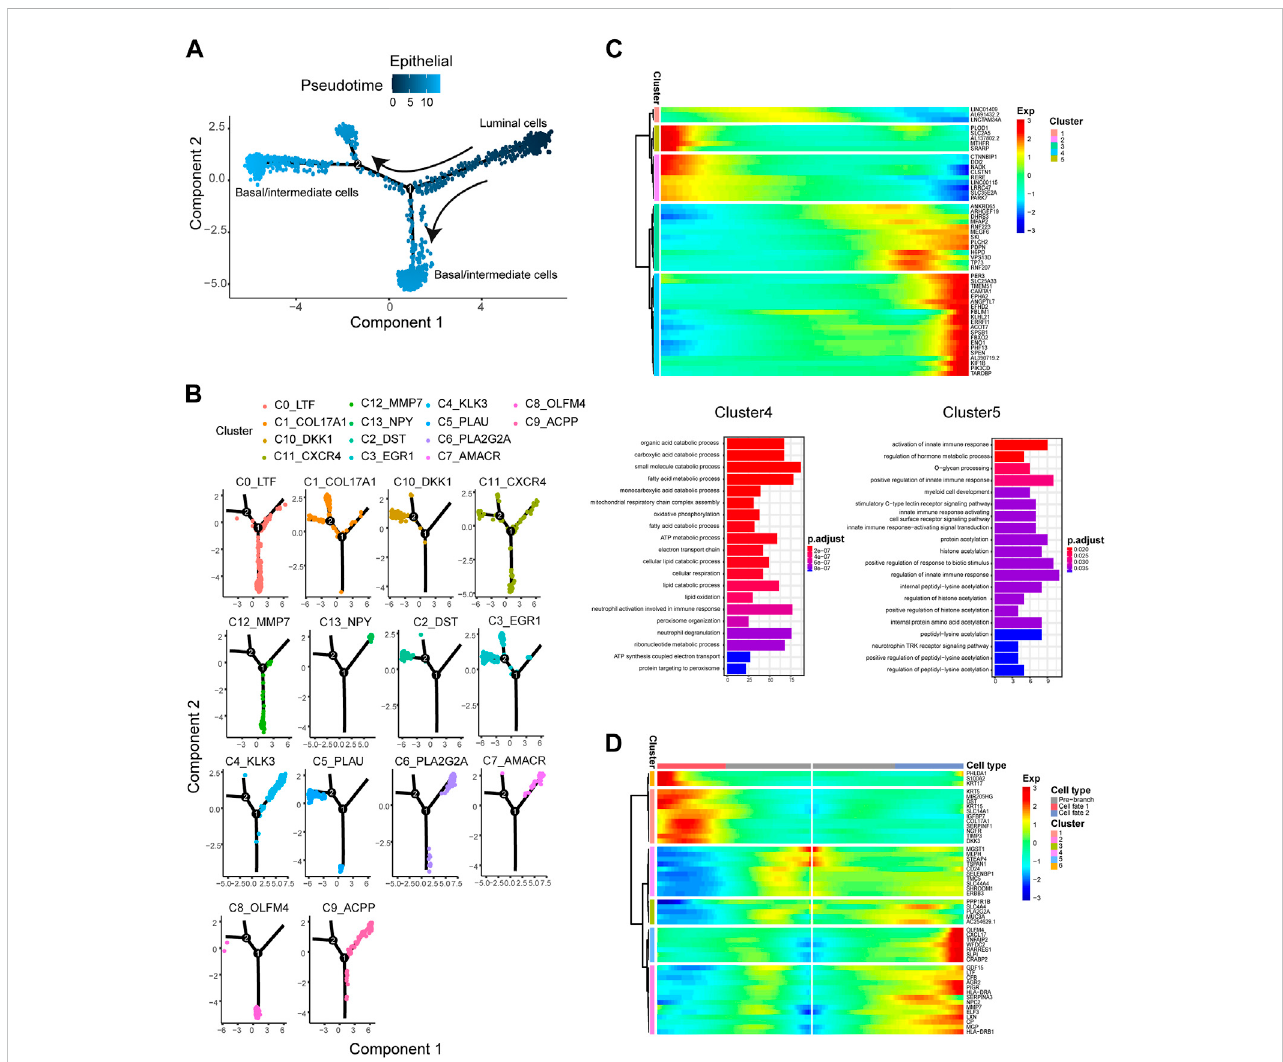
FIGURE 3 The pseudotime trajectory analysis of epithelial cells and identifying genes varied during the trajectory. (A) Differentiation trajectory of epithelial cells constructed by Monocle. (B) The epithelial cell subtypes differentiation trajectoryplot. (C) Upper panel: The top 50 DEGs with the most signi fi cant expression level change over the pseudotime trajectory were classi fi ed into 5 clusters. Lower panel: GO molecular function enrichment heatmap of Cluster 4 and 5. (D) The heatmap shows the expression patterns of the top 50 signi fi cant genes in branched expression analysis